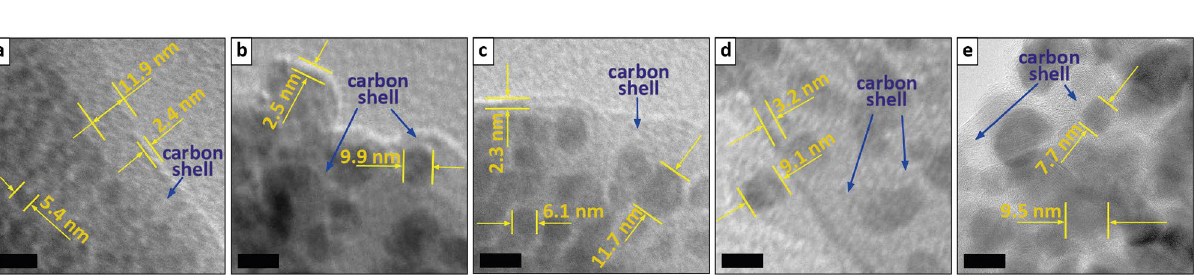
Figure 4. TEM images of the ( a ) Co, ( b ) Co 3 Ni, ( c ) CoNi, ( d ) CoNi 3 and ( e ) Ni NPs. The scale bar equals 10